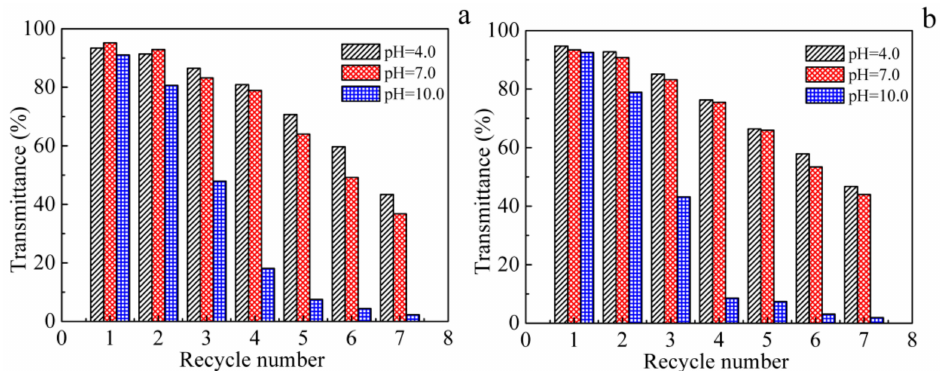
Figure 7. Reusability of MNPs (S1) at various pH levels in diesel oil-in-water emulsion ( a ) and soybean oil-in-water emulsion ( b